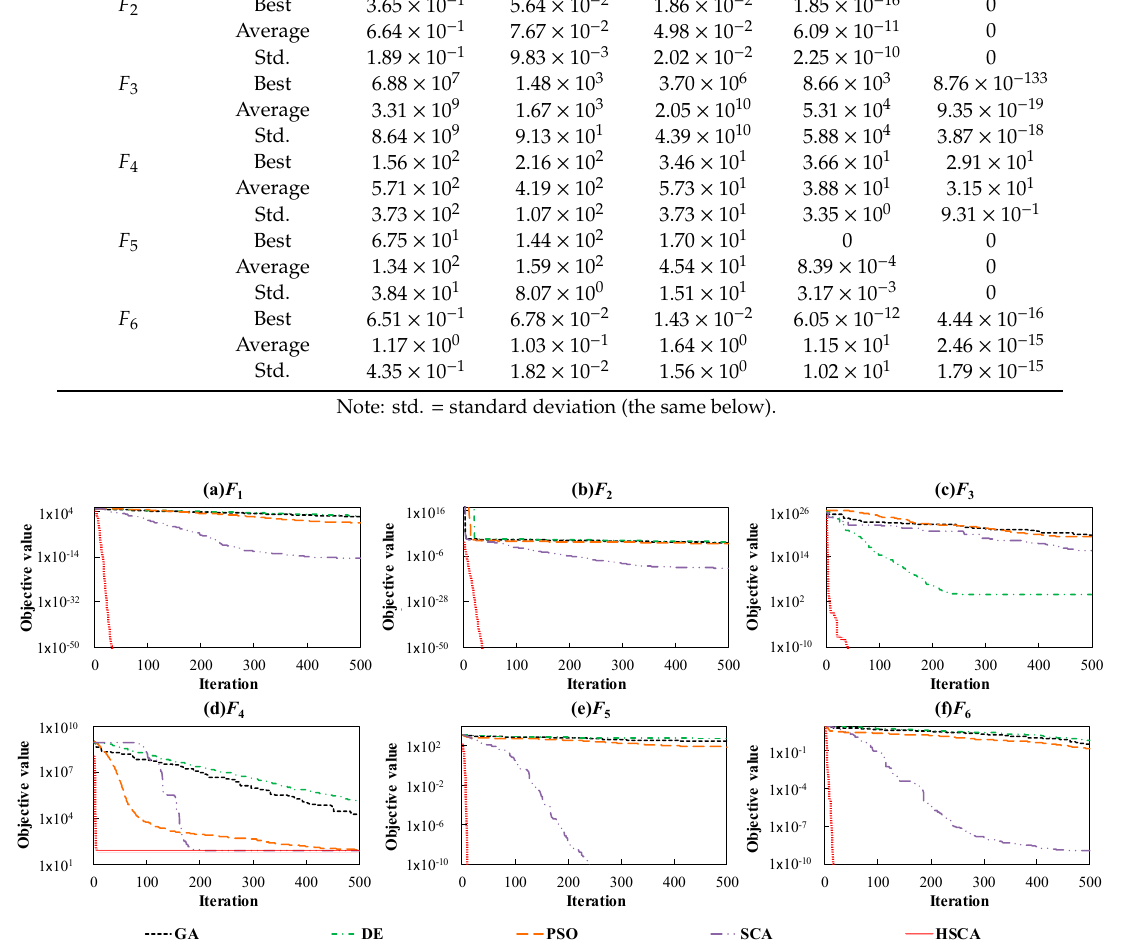
Figure 5. Convergence trajectories of di ff erent methods for test functions in 80 variables. ( a ) F 1 ; ( b ) F 2 ; ( c ) F 3 ; ( d ) F 4 ; ( e ) F 5 ; ( f ) F 6 . Table 4. Experimental results of di ff erent methods for test functions in 80 variables. Function